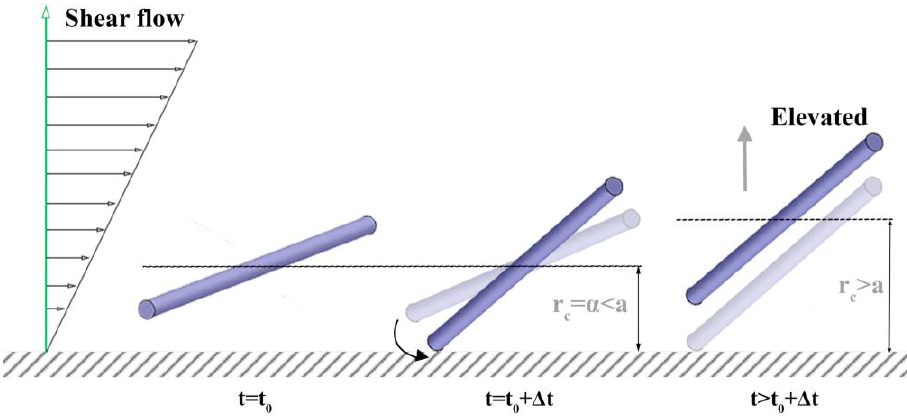
Figure 4. Schematic description for the “Brownian collision” event: Once a tip of a rod invades a boundary, the r c of the rod is lifted without changing its p .